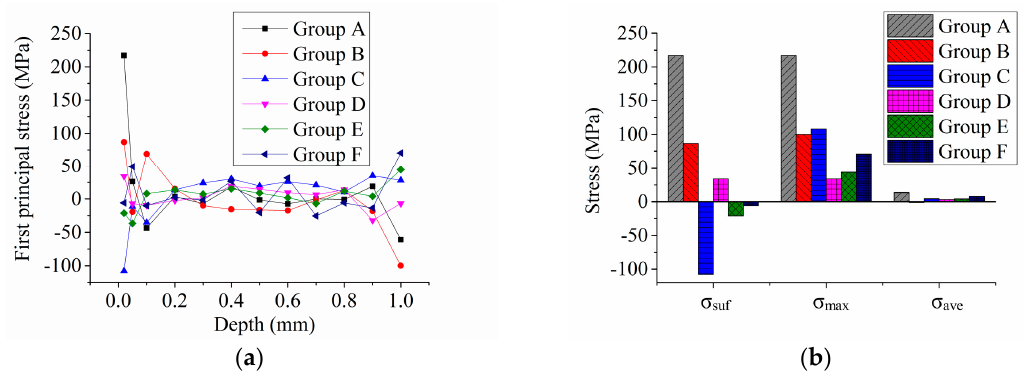
Figure 9. Measured stresses of Groups A to F after the VSR tests: ( a ) first principal stresses along the depth direction; and ( b ) comparison of the measured stress among the different groups (i.e., σ surf , σ max , and σ ave denote the stresses at 0.02 mm depth, absolute value of the peak stress, and average stress along the depth direction, respectively).